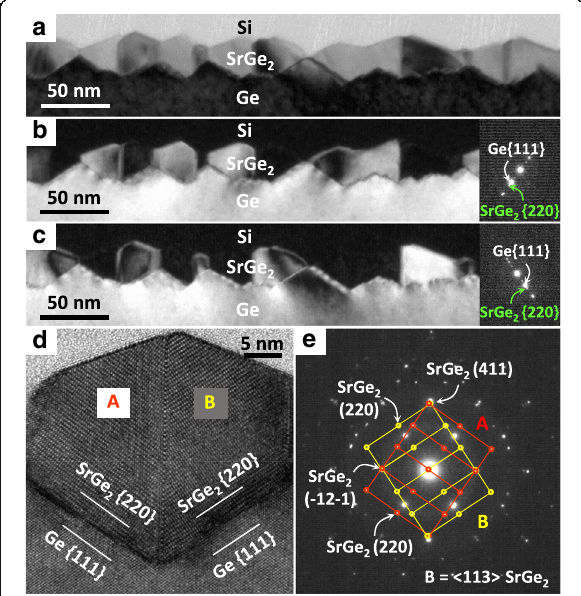
Fig. 4 TEM characterization of the SrGe 2 thin film grown on the Ge (110) substrate at 500 °C. a Bright-field TEM image. b , c Dark-field TEM images using the SrGe 2 {220} plane reflection shown in each diffraction pattern. d High-resolution lattice image showing SrGe 2 crystals. e SAED pattern showing the SrGe 2 〈 113 〉 zone axis, taken from the region including SrGe 2 crystals and the Ge